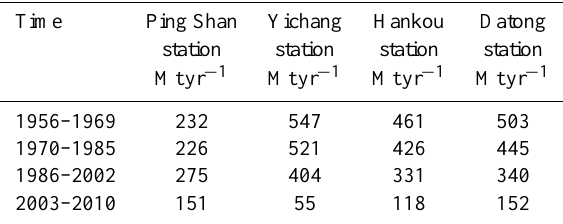
Table 1. The mean value of sediment load of the Changjiang main river during different